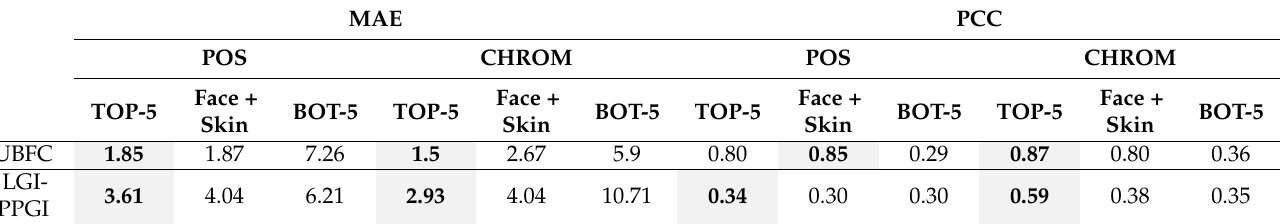
Table 8. Experimental results for TOP-5, Face + Skin, Bot-5.